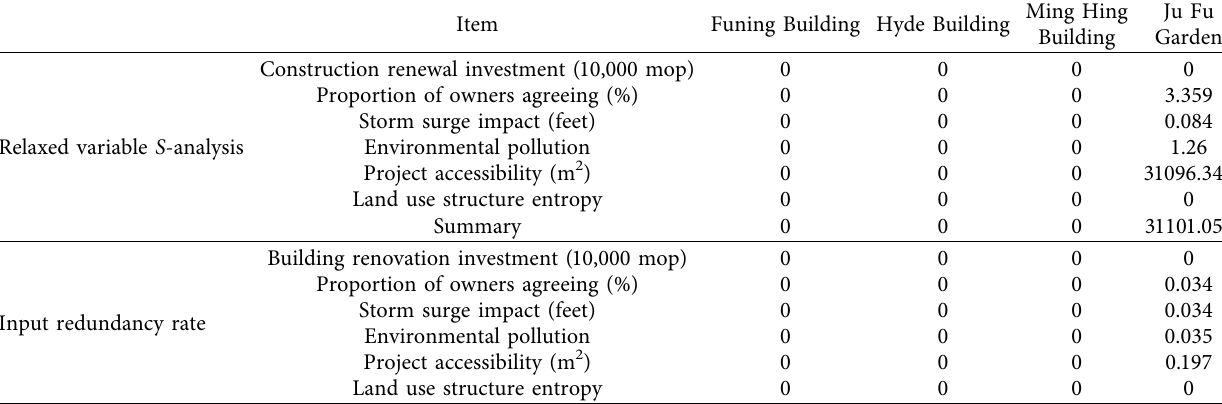
Table 8: Redundancy analysis of investment in the benefts of Macau urban renewal site